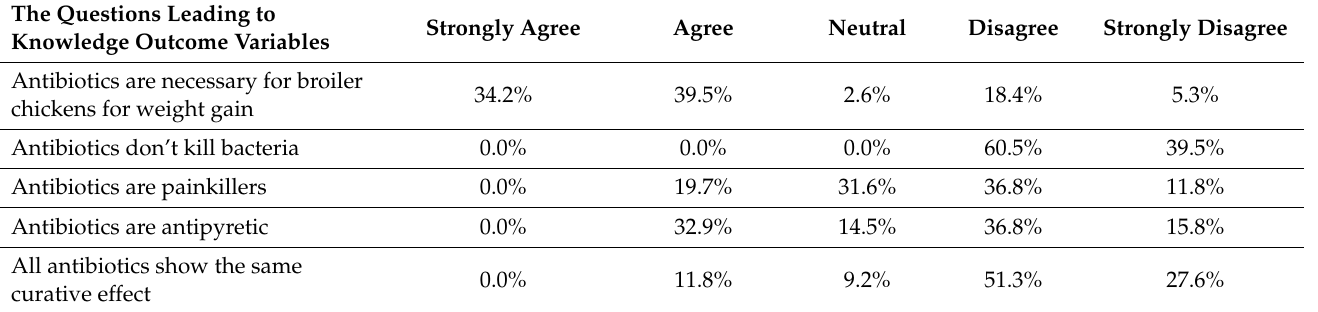
Table 3. Knowledge level of antimicrobial in broiler grower